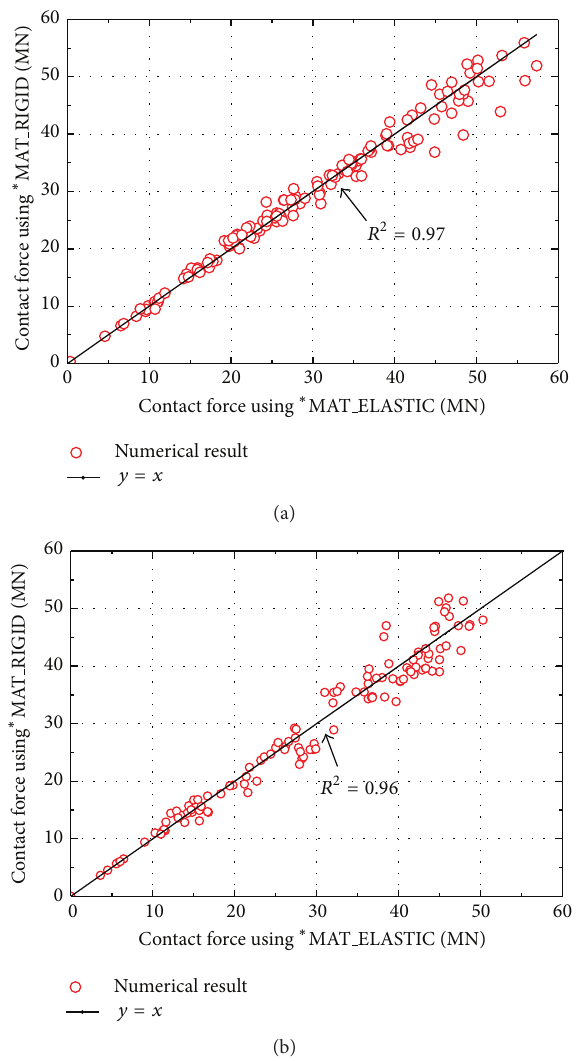
Figure 6: Comparison of contact forces using different mate- rial models in the nonbow vessel portions: (a) 5,000 DWT; (b) 10,000 DWT.